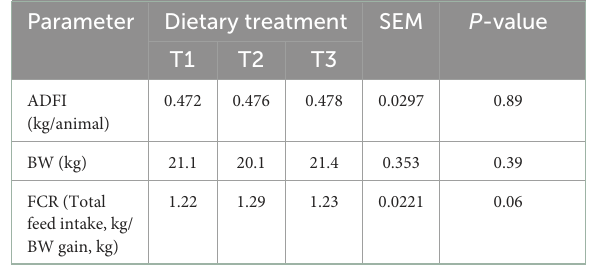
TABLE 4 Parameter selection used to train and evaluate the detection method; this includes the anchor